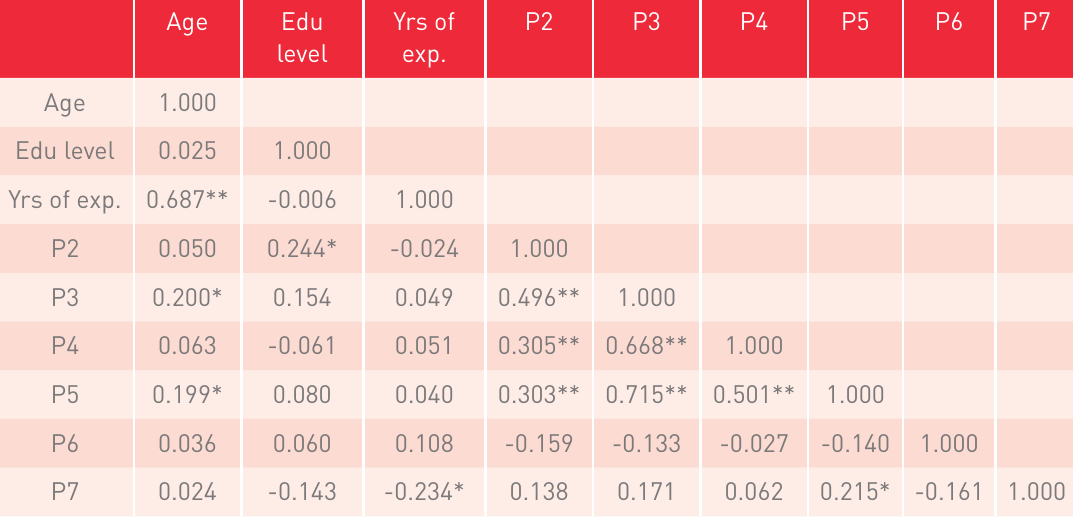
Table 10. Correlations between the respondents’ profile characteristics and